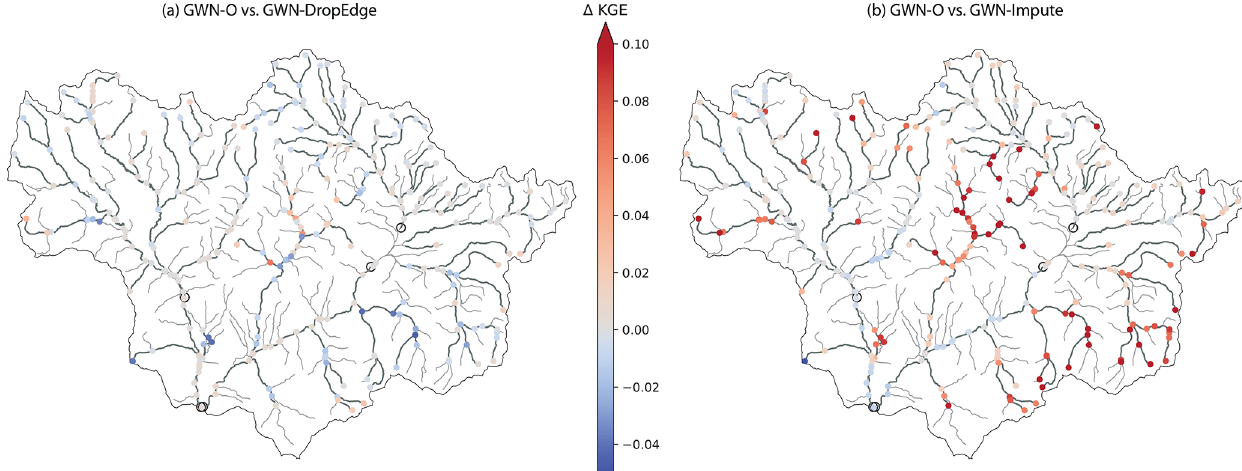
Figure 5. Node-level KGE comparison between the pretrained GWN-O and that of (a) GWN-DropEdge and (b) GWN-Impute.